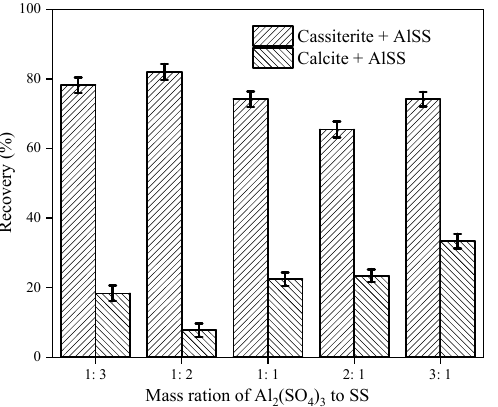
Figure 6. Effect of the mass ratio between Al 2 (SO 4 ) 3 to SS to the flotation recovery of cassiterite and